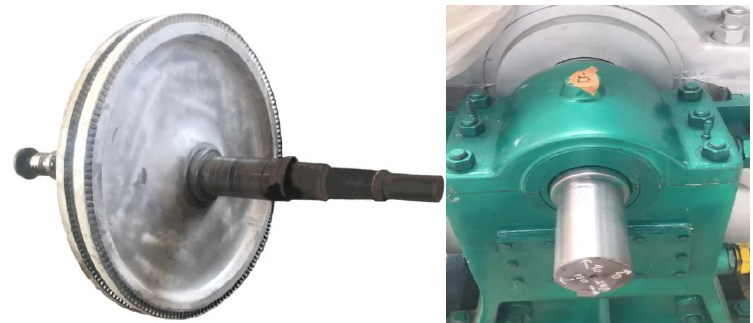
Figure 4. A turbine and shafts.